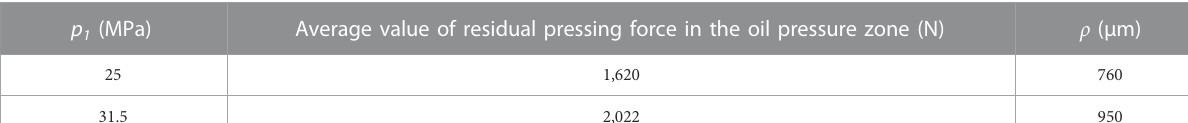
TABLE 5 Test parameters.